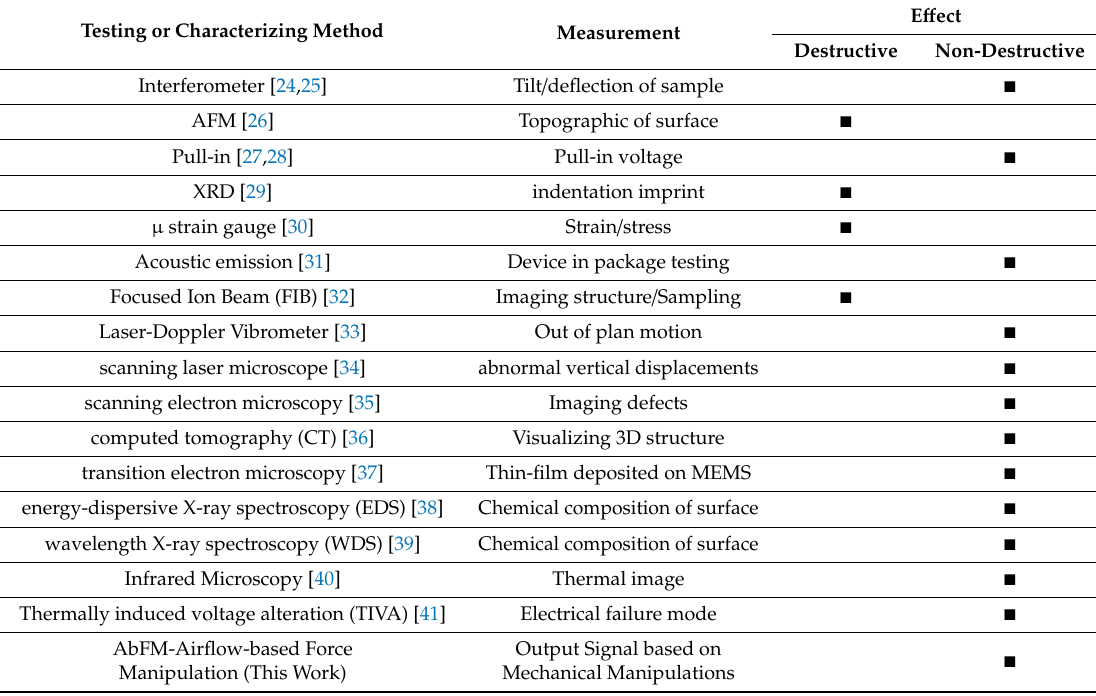
Table 1. Di ff erent Methods for MEMS sensors characterizing and